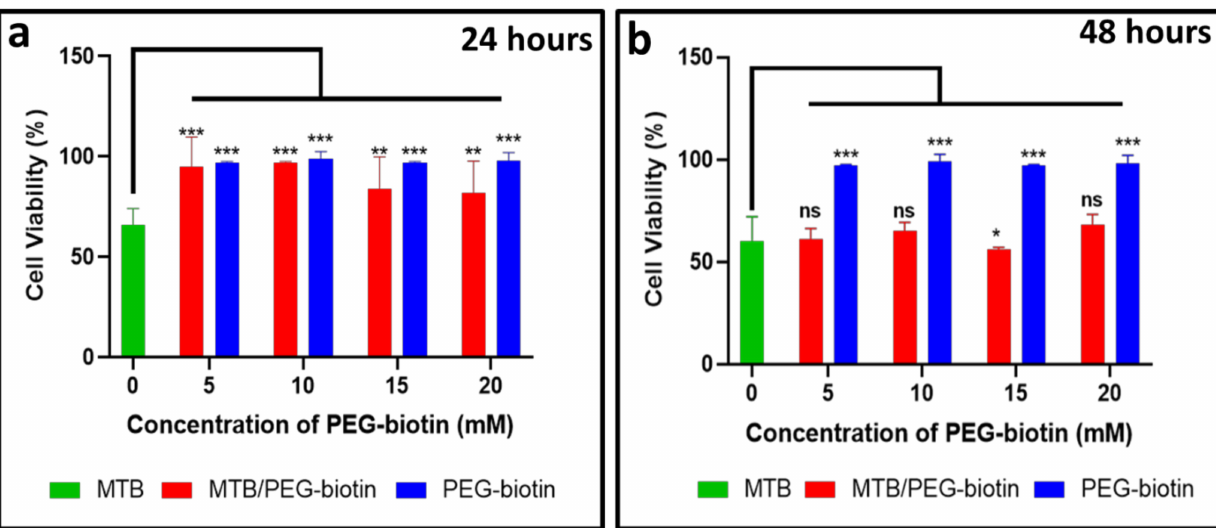
Figure 5. Cell viability assay. THP-1 cells were incubated for ( a ) 24 and ( b ) 48 h at 37 ◦ C with different concentrations of PEG–biotin for the MTB/PEG–biotin complex, and compared to bare MTB and bare PEG–biotin, using the CCK-8 assay. The cell viability was found to be concentration and time-dependent. The results indicate that cells survive long after exposure to bare PEG–biotin and also the THP-1 cells survive long after incubation with MTB/PEG-biotin complex as compared to bare MTB. Statistical analysis was performed using two-way ANOVA. Data are presented as mean ± SD, n = 3. Significant difference was considered for * p < 0.05, ** p < 0.01, *** p < 0.001, and non-significant (ns) for p >